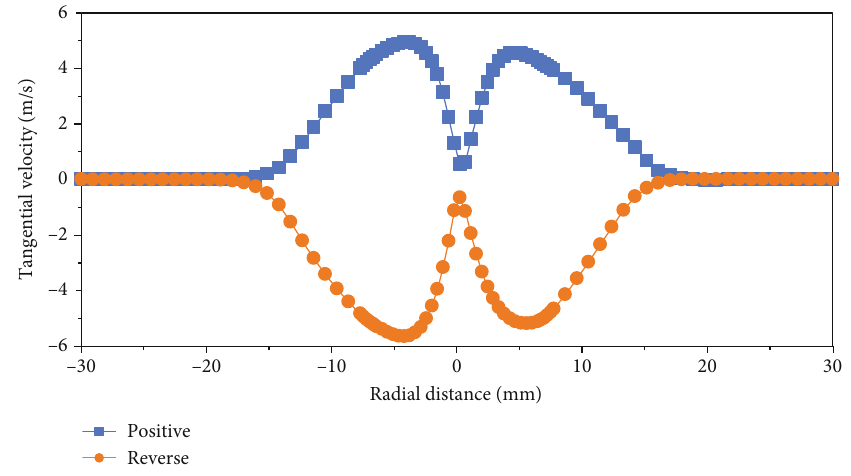
Figure 20: Tangential velocity distribution of positive and reverse swirling in h / d = 8